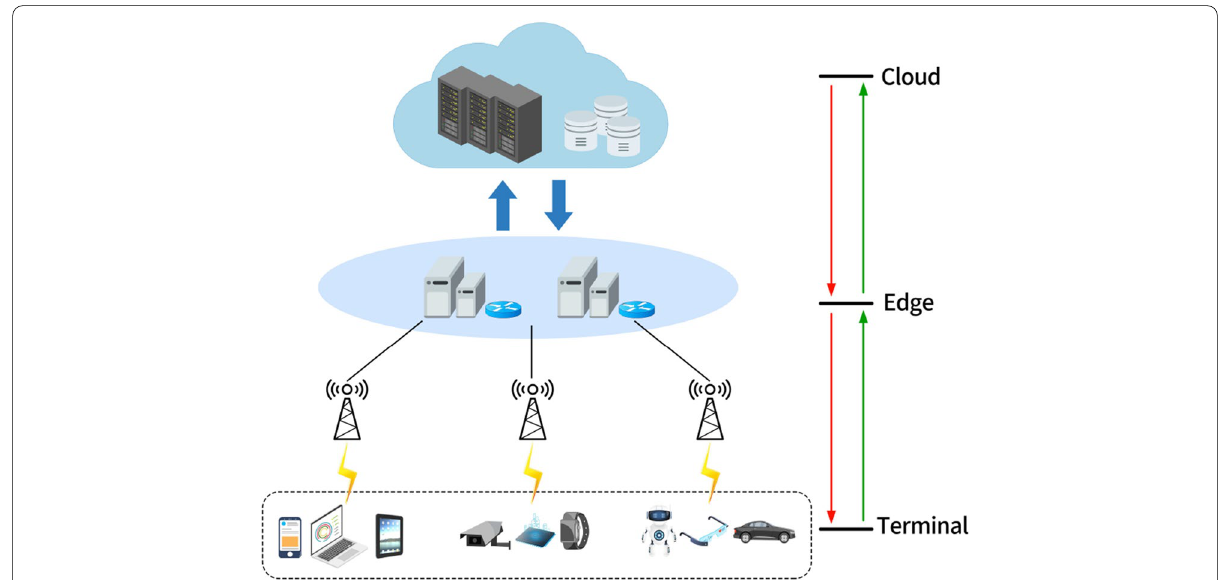
Fig. 1 Architecture of cloud-edge collaborative computing